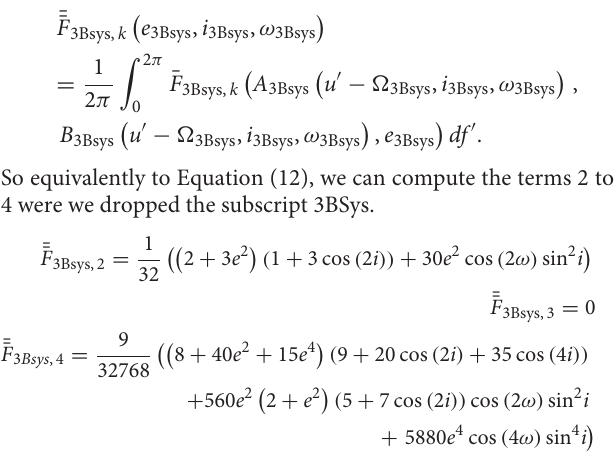
15deg. (E) Initial inclination 20deg. (F) Initial inclination = = 40deg. (J) Initial inclination 45deg. (K) Initial inclination = = 64.2823deg. (O) Initial inclination 65deg. (P) Initial inclination = = 85deg. (T) Initial inclination = =